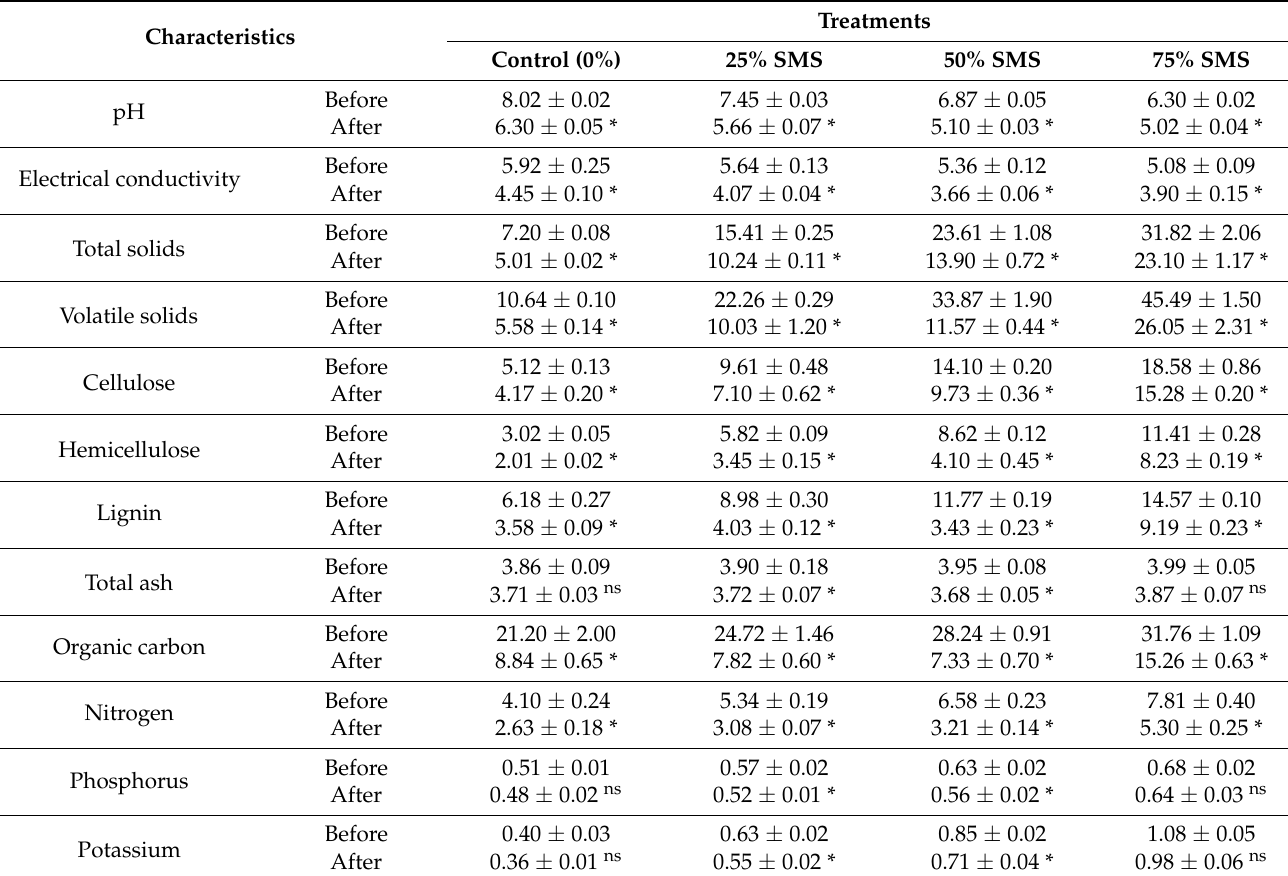
Table 2. Changes in the characteristics of SMS and CD-based biogas slurry before and after AD.